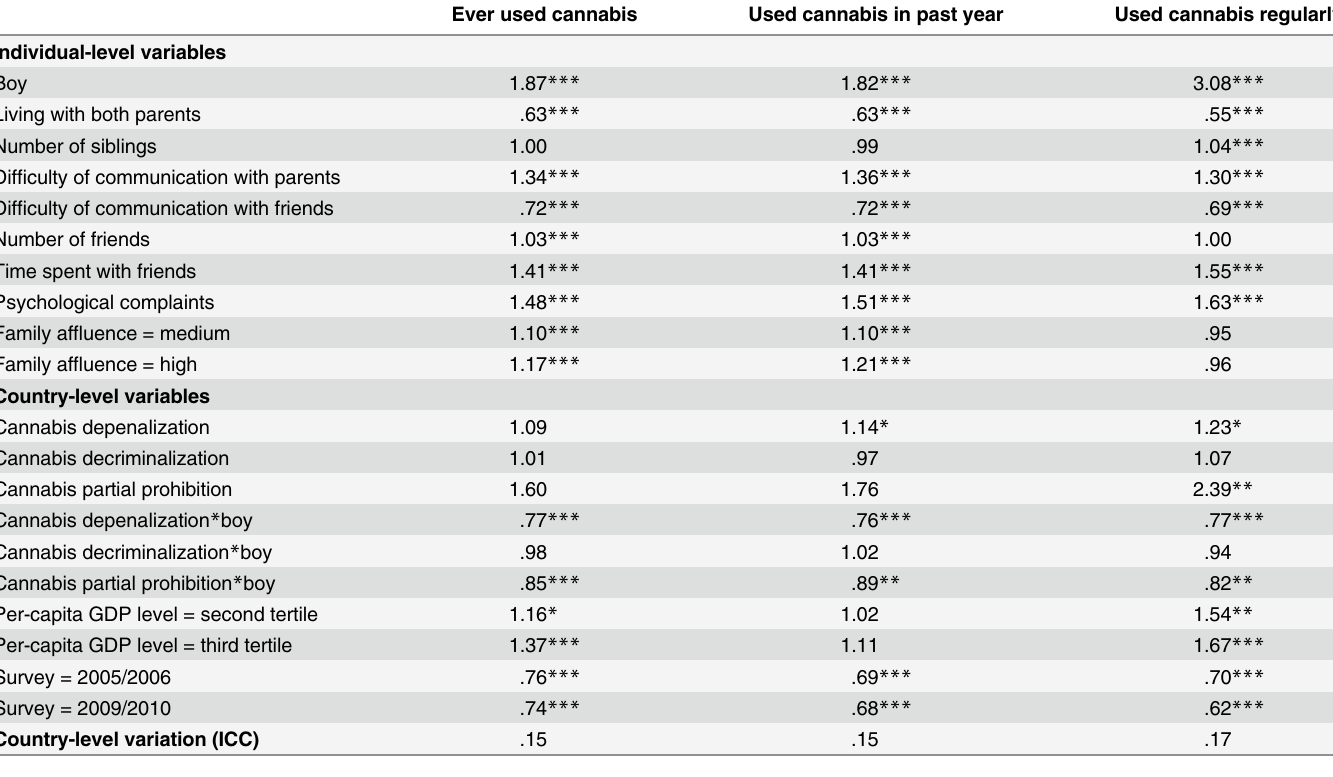
Table 4. Multilevel logistic regressions for adolescent cannabis use status and detailed type of cannabis control policies. HBSC 2001 – 2010 (N = 172,894). Ever used cannabis Used cannabis in past year Used cannabis regularly